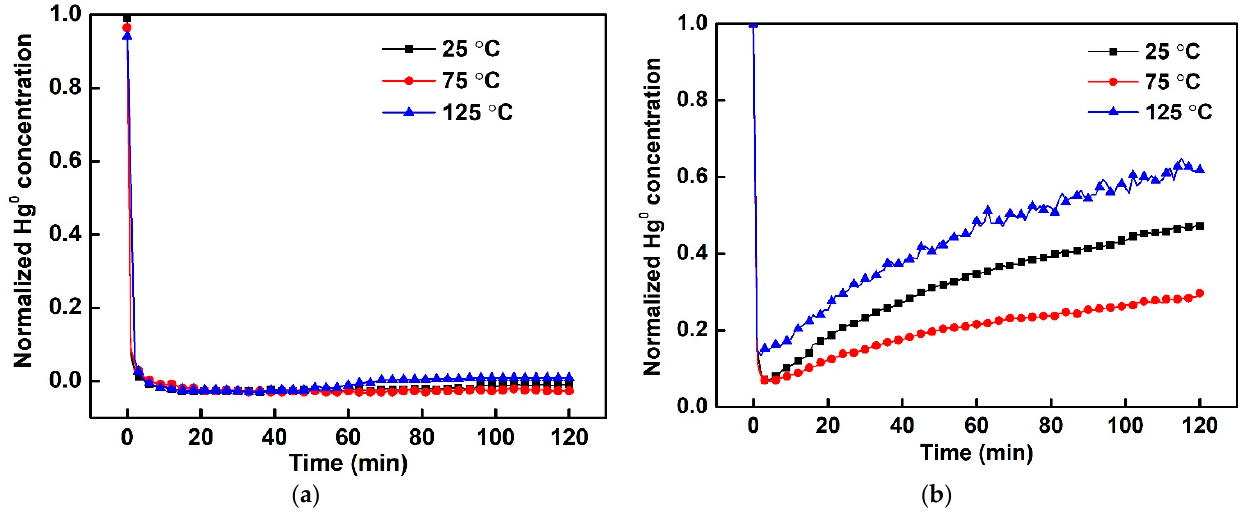
Figure 9. Hg 0 removal performances of ( a ) S-C and ( b ) S/C under different temperatures.